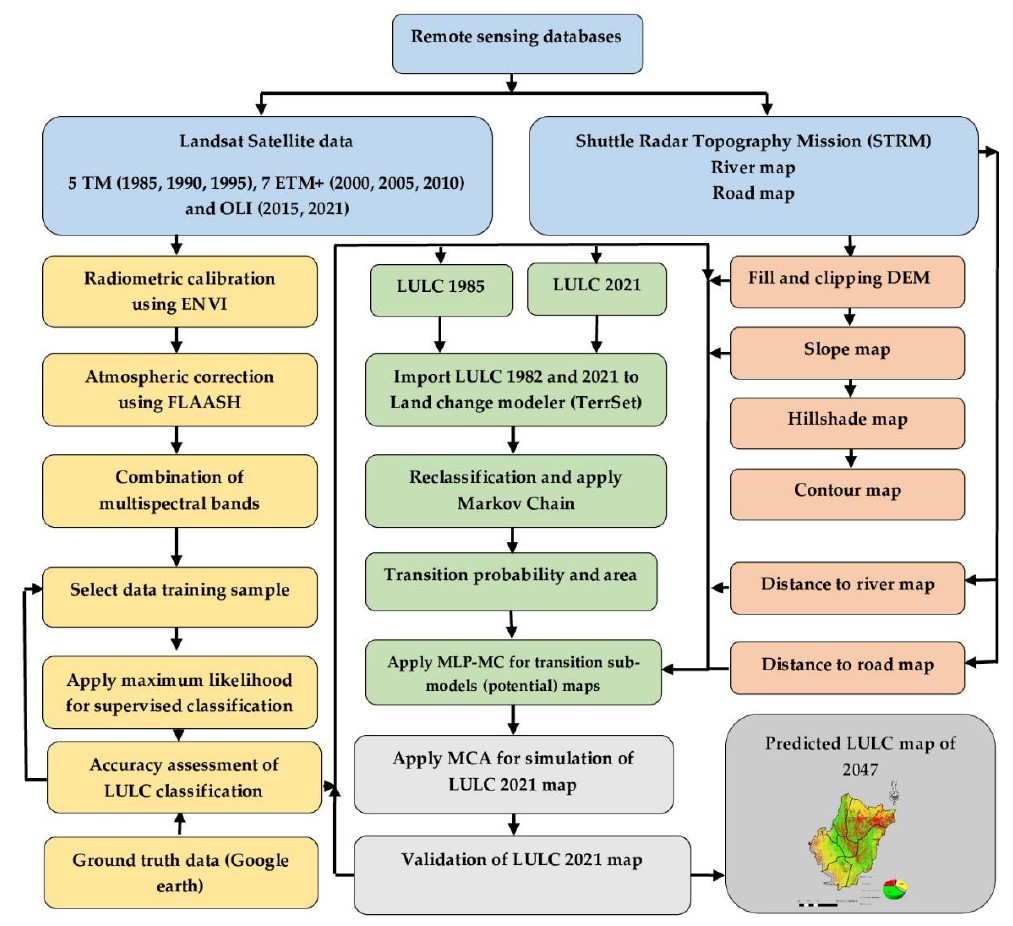
Figure 3. Flowchart used in this study.